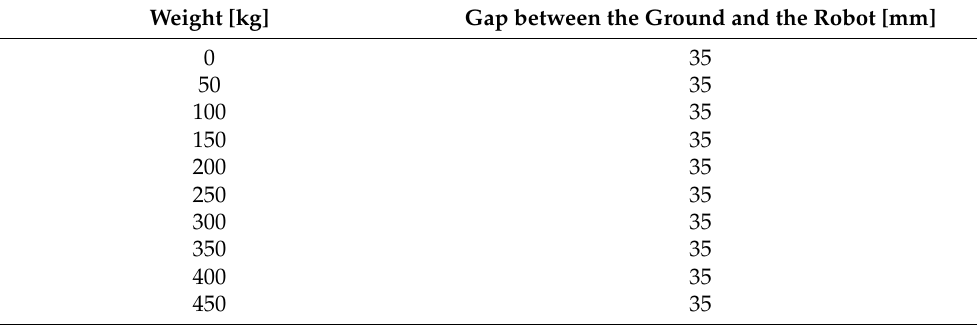
Figure 11. Load testing in a real environment. Table 3. The case of a centralized load.